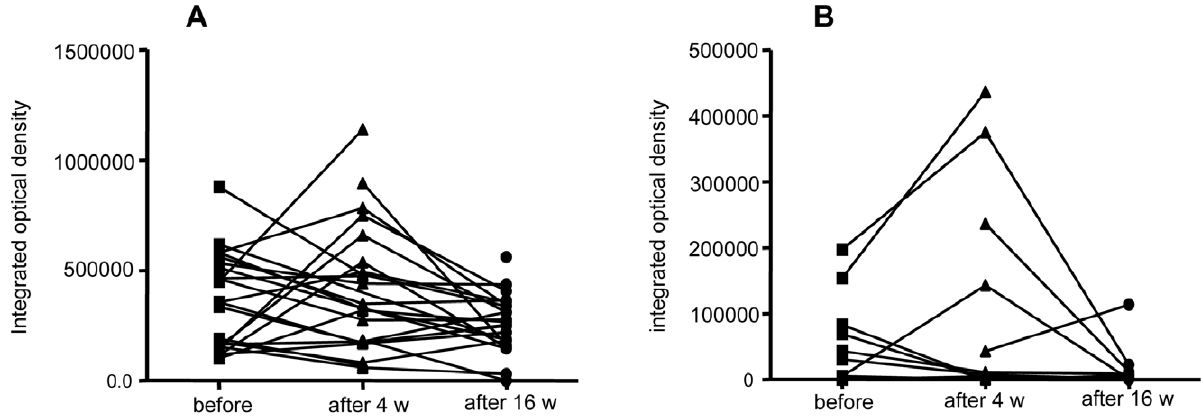
Figure 6. Rituximab treatment exerts limited effects on the synovial tissue expression of IL-1 b and IL-6. Graphs show image analysis of positive stained sections for (A) IL-1 b and (B) IL-6 before and at consecutive time points after initiation of rituximab therapy. At week 16 a trend towards decrease occurred in IL-6 but not in IL-1 b .